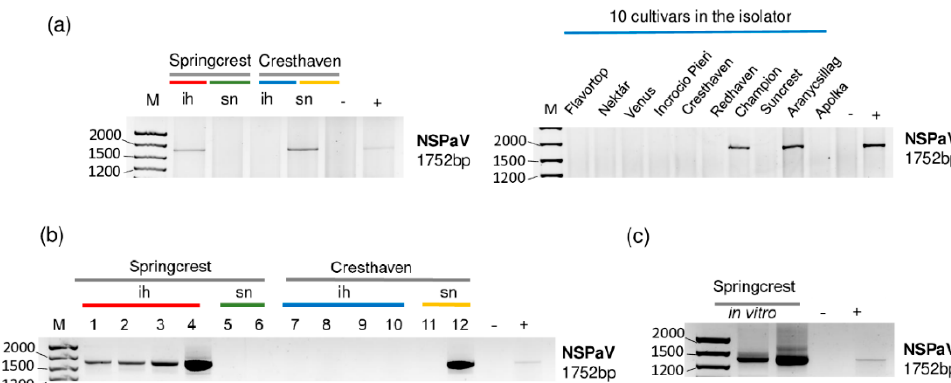
Figure 4. The result of the RT-PCR validation for the presence of NSPaV in the sRNA HTS libraries and individual trees ( a , b ) using NSPaV-specific primers amplifying a 1752 bp virus-specific amplicon. ( c ) The result of the RT-PCR validation of NSPaV in in vitro plantlets whose ancestors were used using NSPaV-specific primers amplifying a 1752 bp virus-specific amplicon. M is a GeneRuler 100 bp from Thermo Scientific (Waltham, MA, USA). ih: isolator house; sn: stock nursery; + is a positive control; − is a negative control.